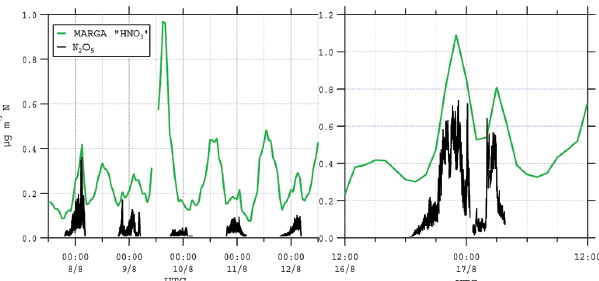
Fig. 2. Expanded time series of the effect of N 2 O 5 on the detection of HNO 3 by an aqueous denuder technique. Left panel: 7 August to 12 August 2012. Right panel: 16 to 17 August